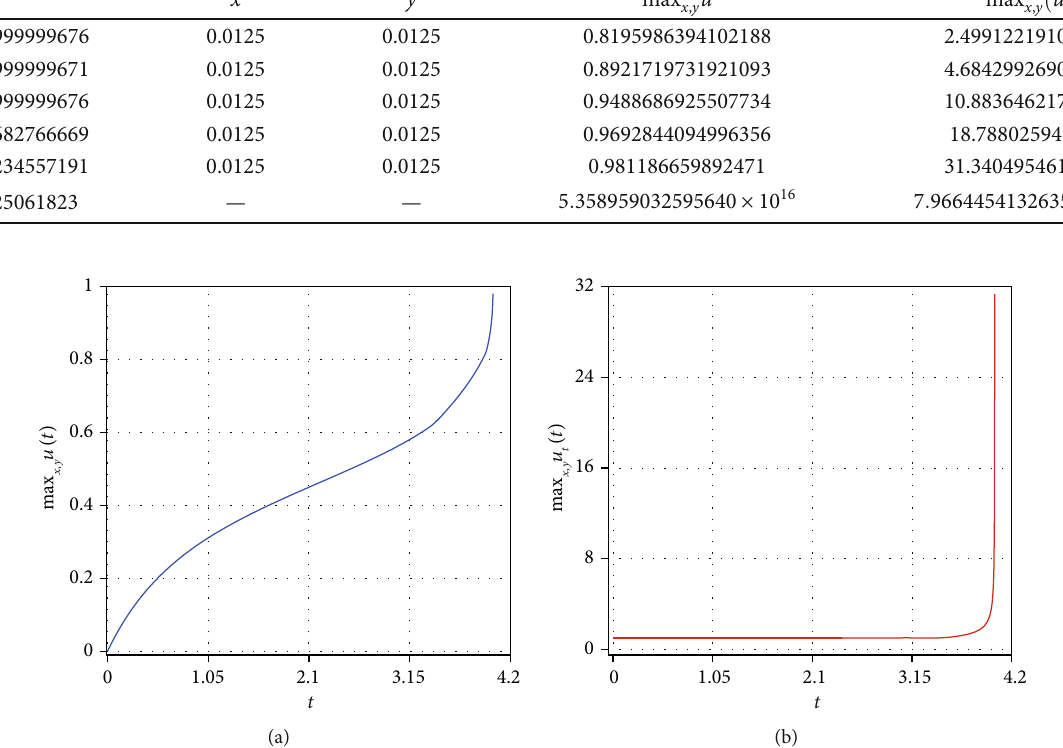
max u as t increases, and (b) max t : (a) x , y ffiffiffiffiffiffiffiffiffiffiffiffi p 11000 based on convection term b / ð α x + β y Þ